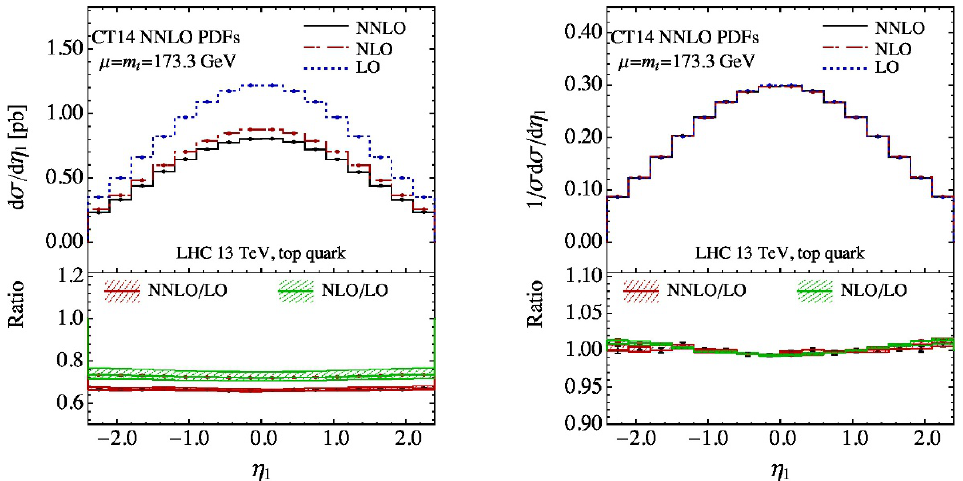
Figure 25 . Predicted pseudo-rapidity distribution of the charged lepton from t -channel single top-quark production and decay at 13 TeV after (cid:12)ducial cuts, including full corrections, with and without normalization respectively.